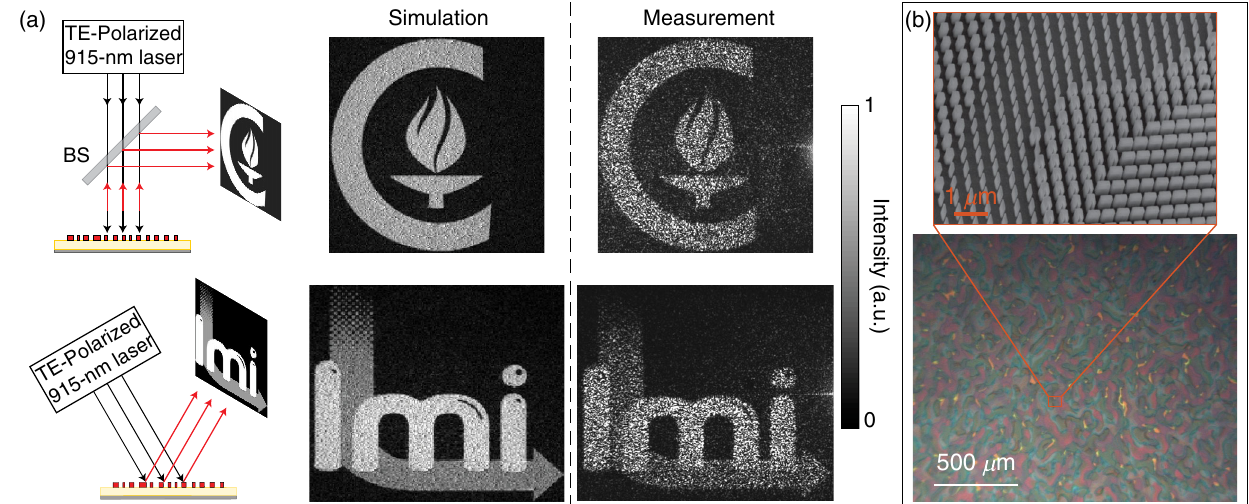
FIG. 4. Angle-multiplexed hologram. (a) Simplified drawing of the measurement setups under normal and 30° illumination angles (left). The angle-multiplexed hologram is designed to create two different images under different incident angles (Caltech and LMI logos under 0° and 30°, respectively). Simulated and measured reflected images captured under 915-nm TE-polarized light at 0° and 30° illumination angles are shown on the right. See Appendix B and Ref. [63] (Fig. 3) for measurement details. (b) Optical image of a portion of the angle-multiplexed hologram. The inset shows a scanning electron micrograph under oblique view of meta-atoms composing the metasurface. See Appendix B for fabrication